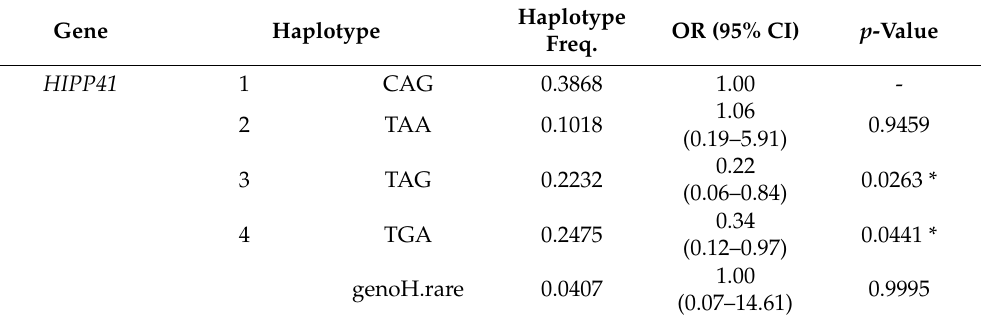
Table 5. Significant results of the haplotype association analysis. All analyses were performed with SNPassoc using a logistic regression